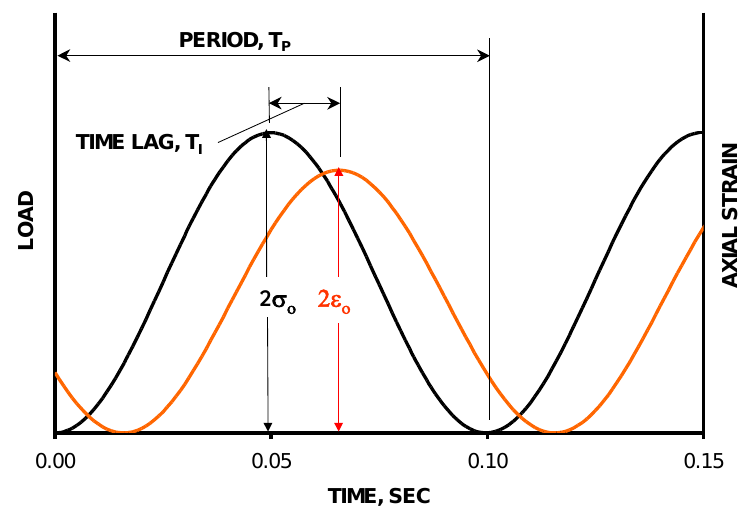
Figure 2. Loading mode of dynamic modulus test.